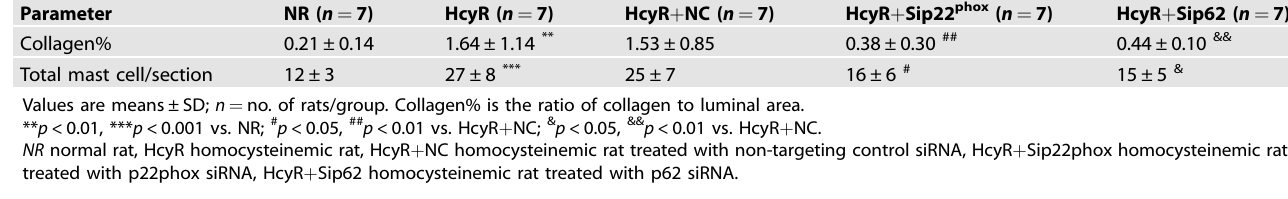
Table 1. Effect of sip22 phox or sip62 administration on myocardial fi brosis and mast cell in fi ltration in the left ventricle from HcyR. Parameter